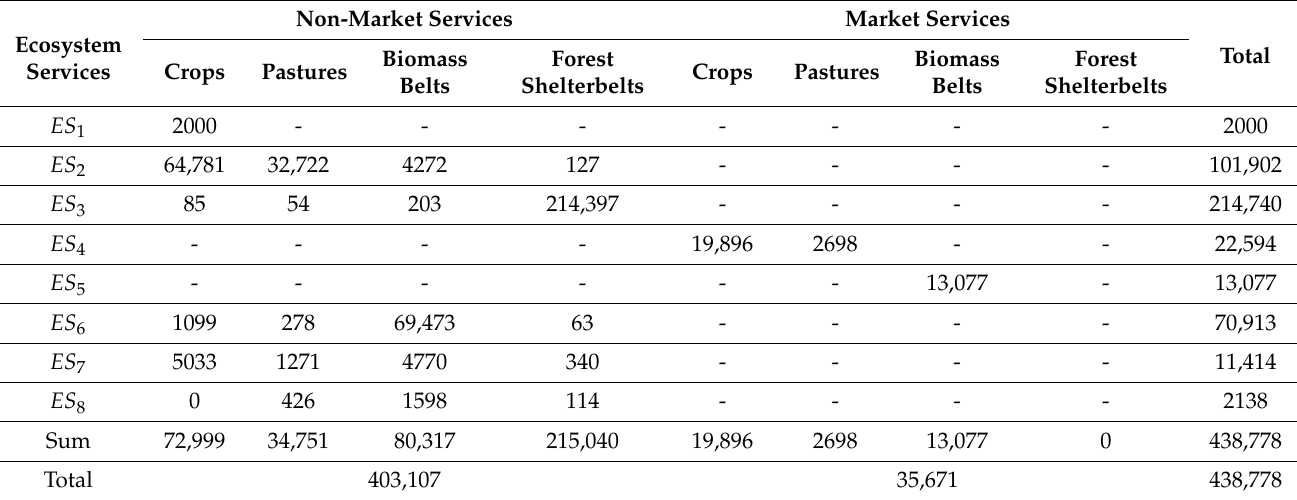
Table 5. Economic value of ecosystem services in a land protection and bioenergy production scenario, thousand UAH y − 1 . Ecosystem